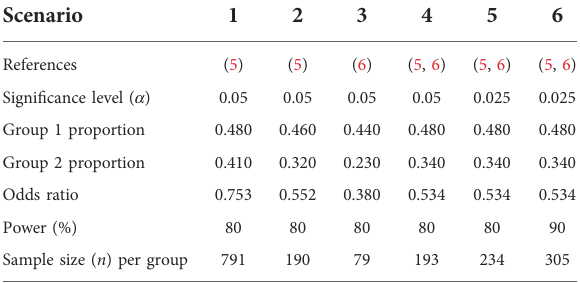
TABLE 1 Different scenarios for sample size calculations for a RCT investigating the effect of oxygen strategies on the progression to ophthalmologic treatment for ROP a